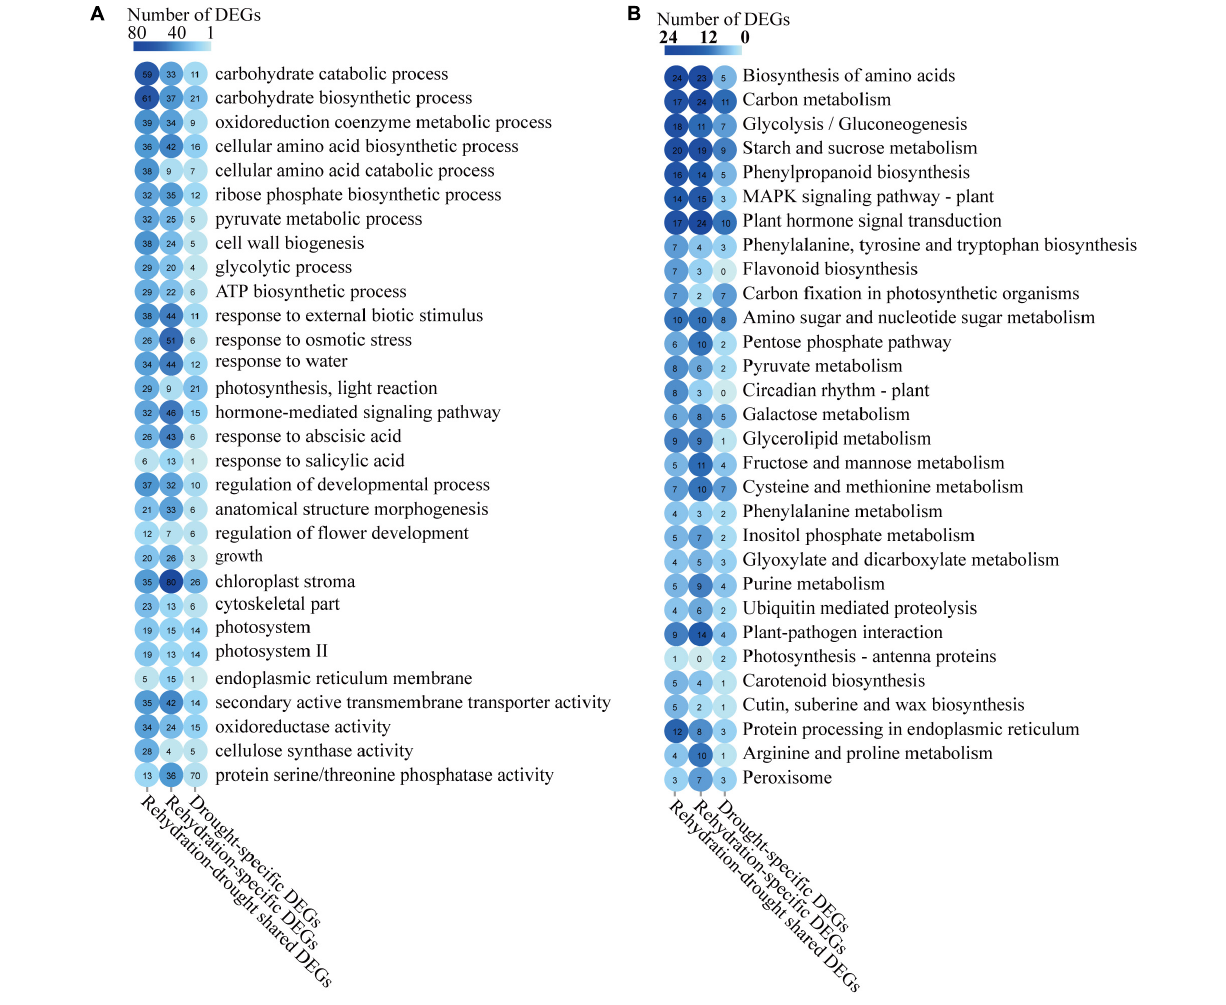
Frontiers in Plant Science |